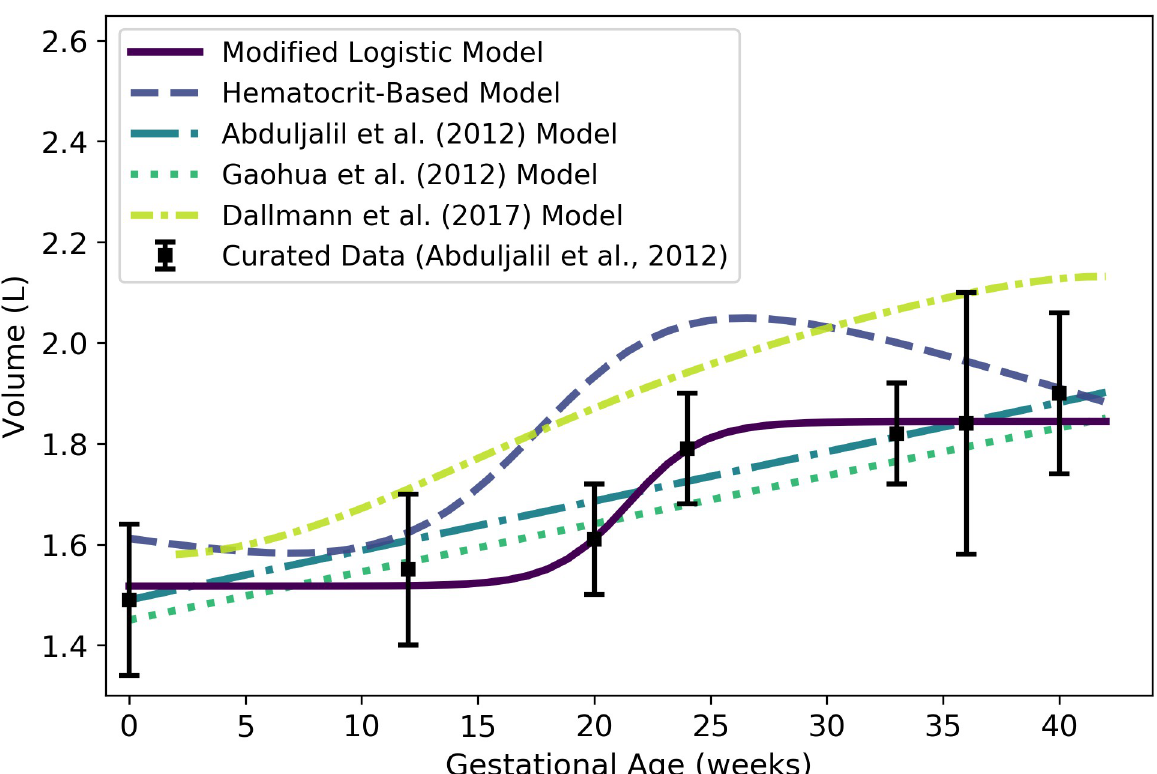
Fig 5. Maternal RBC volume vs. gestational age. The modified logistic model (solid line) given by Eq 6 was selected as the most parsimonious model in our analysis, but the hematocrit-based model (second in legend) of Eq 7 ensures consistency with models for plasma volume (Eq 5) and hematocrit (Eq 24). The models of Abduljalil et al. [28] and Gaohua et al. [29], both of which are linear models, were calibrated using the same curated data set [28] used by us. Dallmann et al. [3] did not create a model for maternal RBC volume, so the model attributed to them here is algebraically derived from their models for plasma volume and hematocrit.